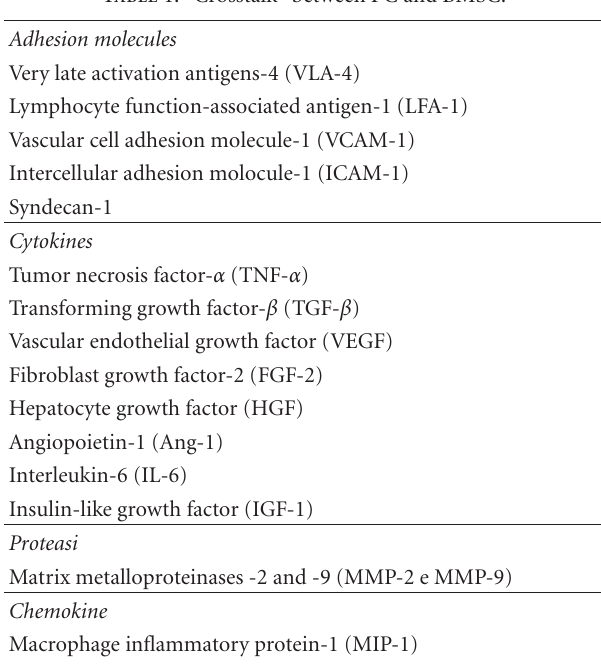
Table 1: “Crosstalk” between PC and